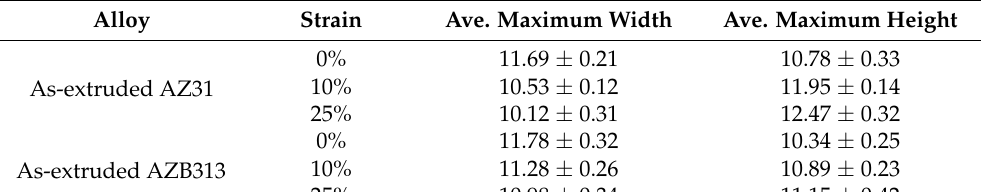
Figure 11. Quasi in situ SEM images of two as-extruded alloys subjected to hot compression at dif- ferent strains: 0, 10, and 25% strains for ( a – c ) as-extruded AZ31 alloy and ( d – f ) as-extruded AZB313 alloy, respectively.